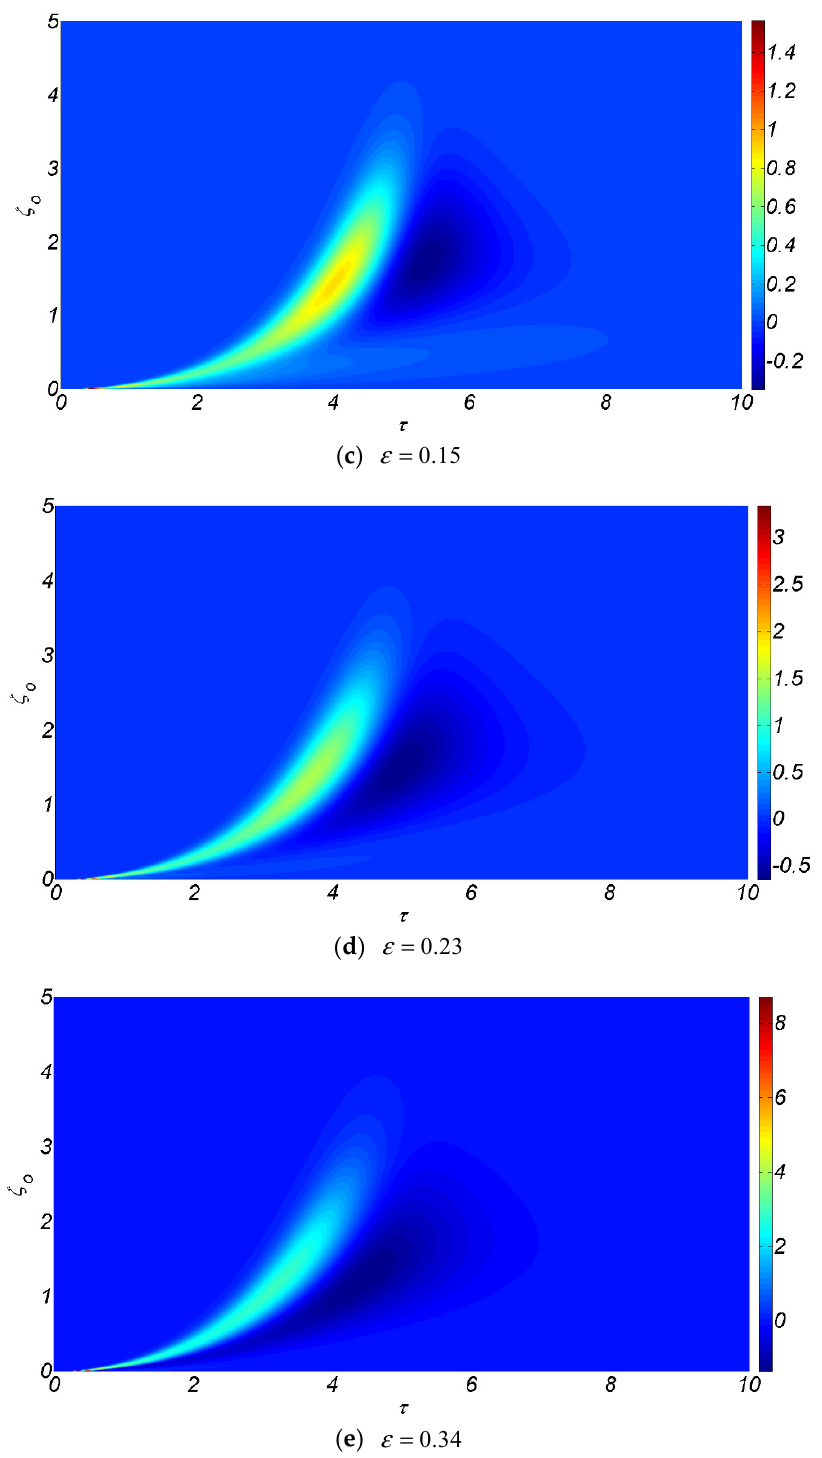
Figure 9. Evolution of joint distribution of wave crest height and its associated period as nonlinearity is enhanced.